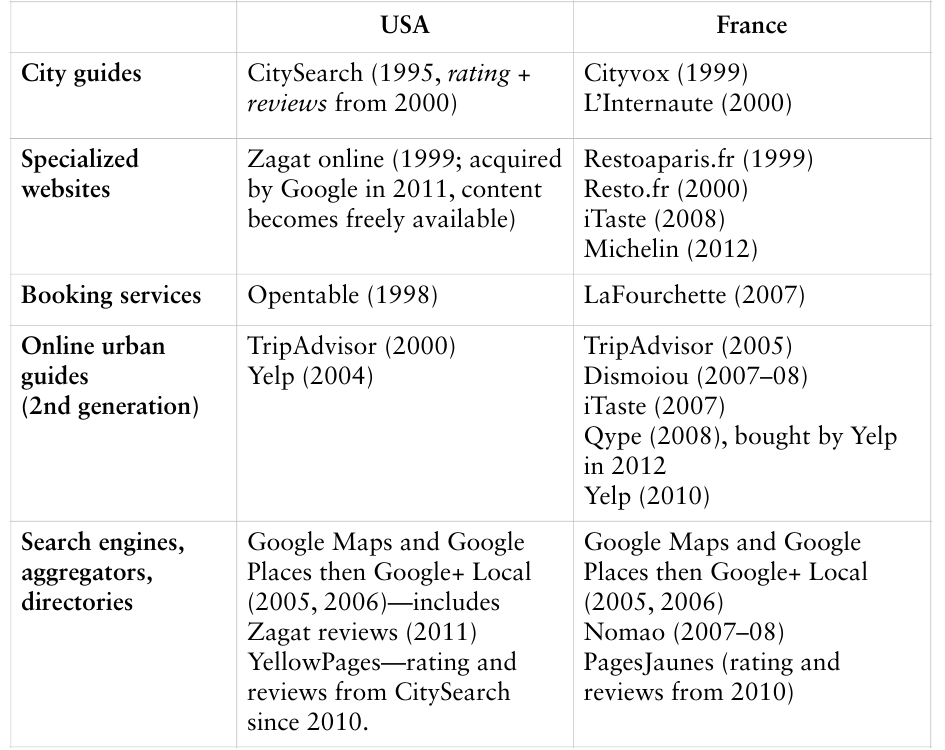
Table 2. OCR in the restaurant industry—historical marks.